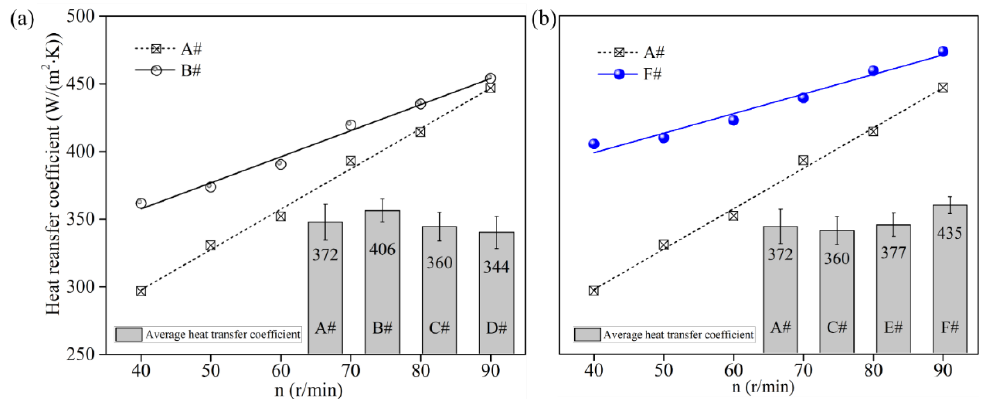
Figure 6. Convective heat transfer coefficient ( α ) for various screws: ( a ) Variable TOE numbers; ( b ) Dispersed arrangement of TOEs.